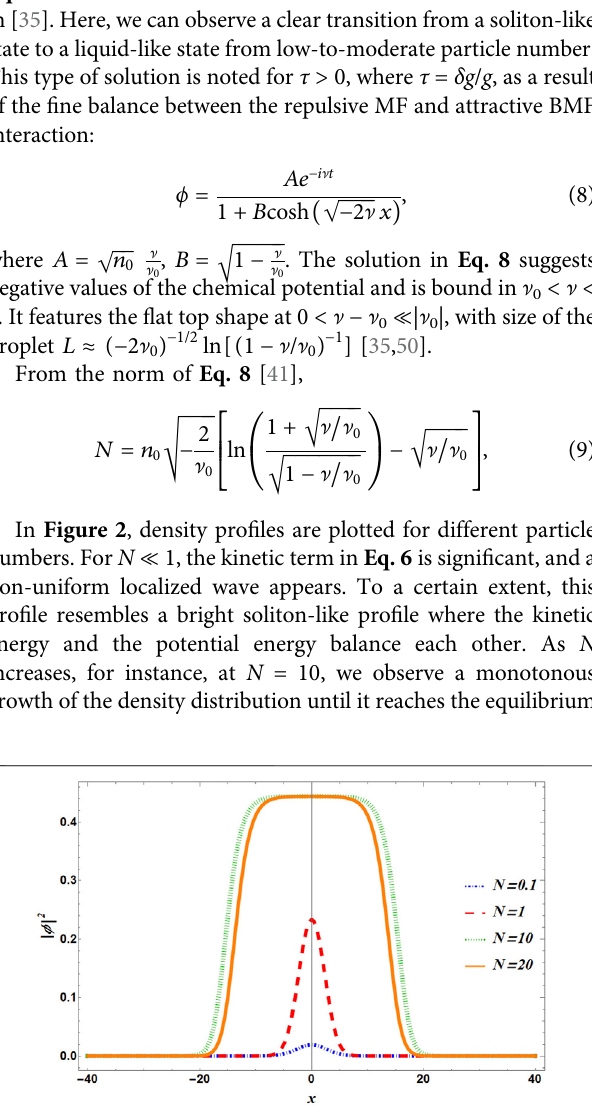
FIGURE2| (ColorOnline)Spatialvariationofdensitycalculatedfrom Eq. 8 for different particle numbers. A lower particle number yields a localized solution ( N = 0.1, 1), whereas the larger number of particles ( N = 10, 20) leads tothebulk regiondescribedbythe fl at plateau.The dot-dashed blue line isusedfor N =0.1,dashedredlineisusedfor N =1,dottedgreenlinedenotes N = 10, and solid orange line is for N =